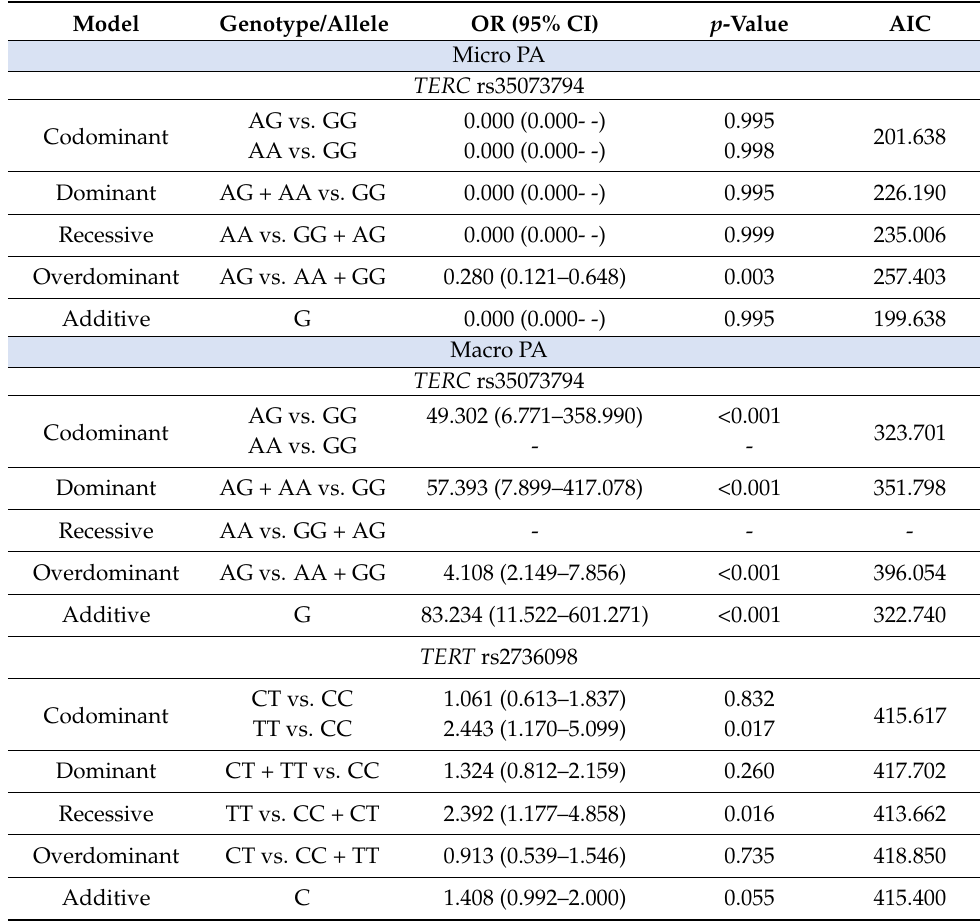
Table 11. Binary logistic regression analysis within micro or macro PA and control group